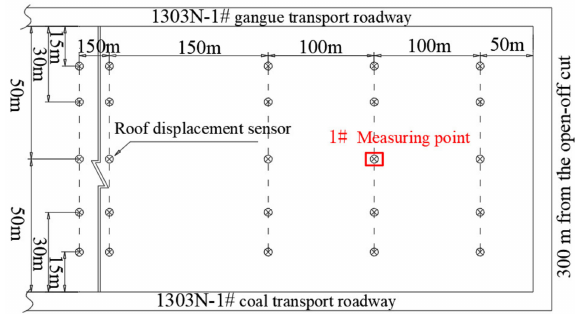
Figure 12. Measuring-point layout of roof displacement.